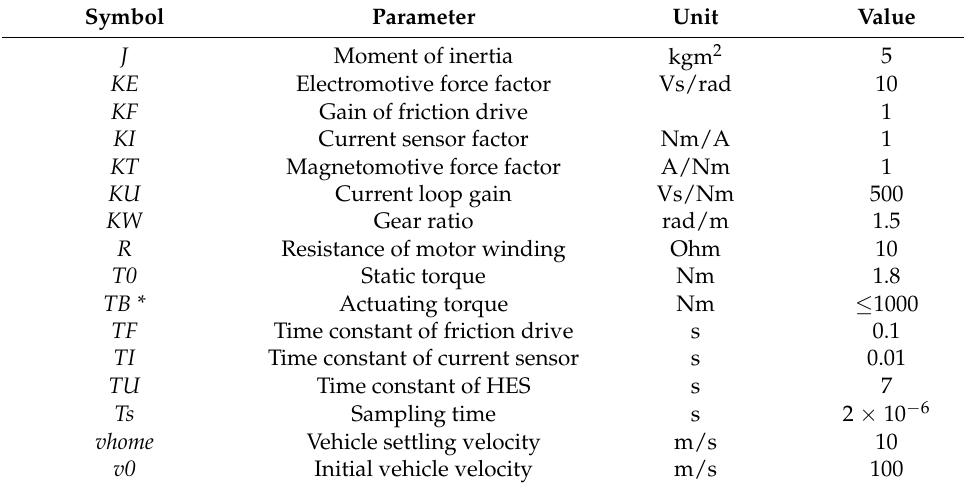
Figure 4. The Wheel block of the PBEV. The data used in the simulation are presented in Table 1. Table 1. The data used in the PBEV simulation.